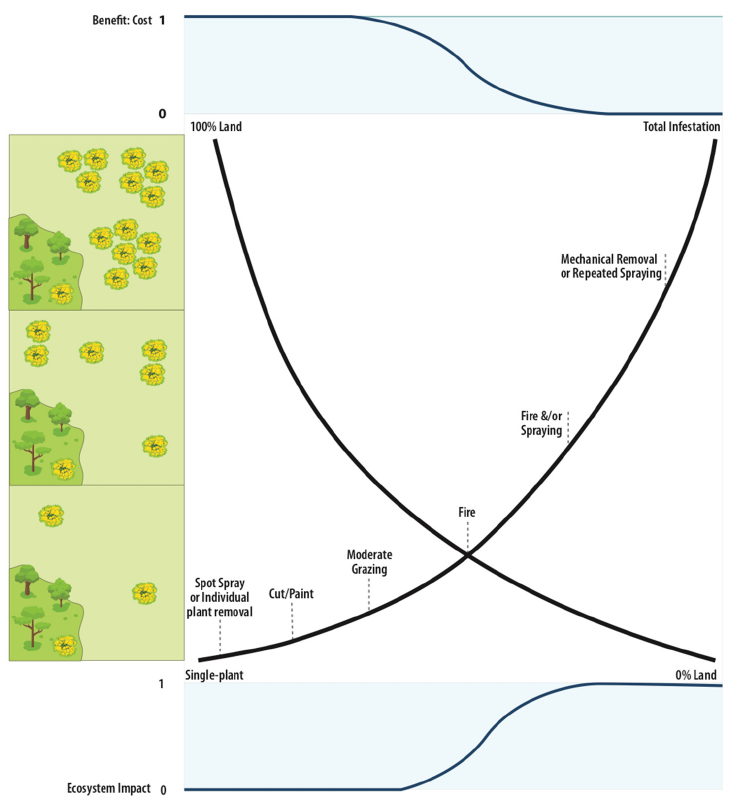
Figure 4. Management strategies for the control of gorse within landscapes, depicting each management strategy in relation to the density of gorse covering the landscape (bottom left to top right) and the proportion of the overall land area occupied (bottom right to top left). Increasing plant density is generally synonymous with more invasive management techniques, ranging from spot spraying of individual plants to mechanical removal of large infestations. With the use of more invasive techniques, the negative impact on ecosystem services increases rapidly (“ecosystem impact”, bottom of figure), whilst the associated benefit-cost ratio (top of figure)